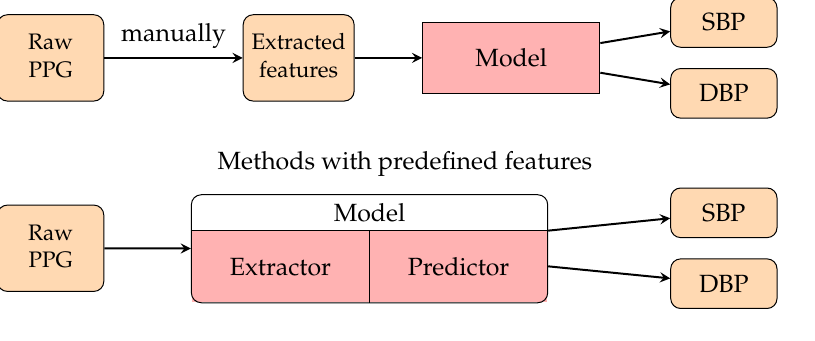
Figure 9. The flowchart of general PPG waveform-based methods. (upper flowchart) [123,125,127,128,136]. Features inside training data of raw PPG signals are manually extracted to train their studied models and give the predictions for SBP and DBP. (lower flowchart) [133,135,137,145]. The whole waveform profiles of raw PPG signals are put into models, which automatically pick up useful features and give predictions for SBP and